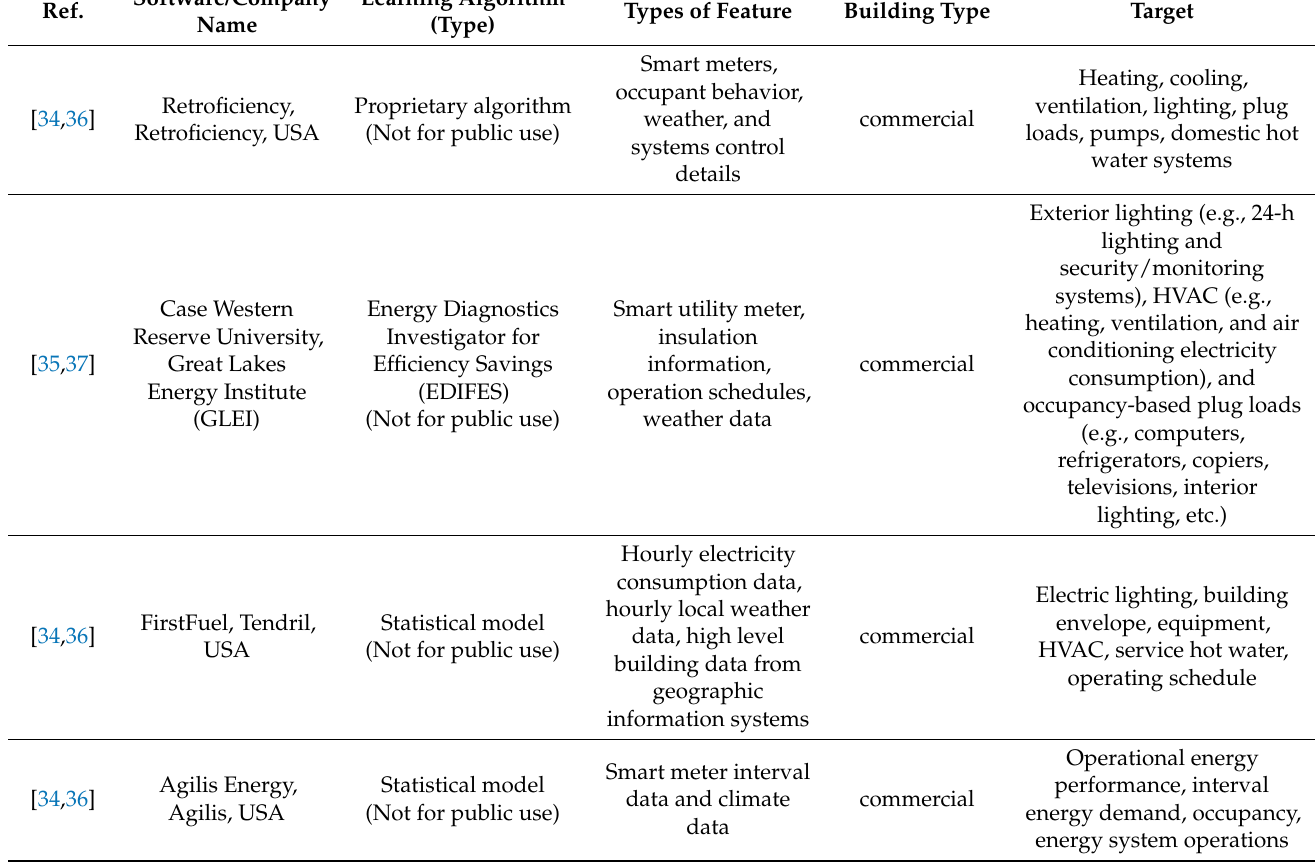
Table 1. Summary of prior research in predicting energy characteristics in buildings.